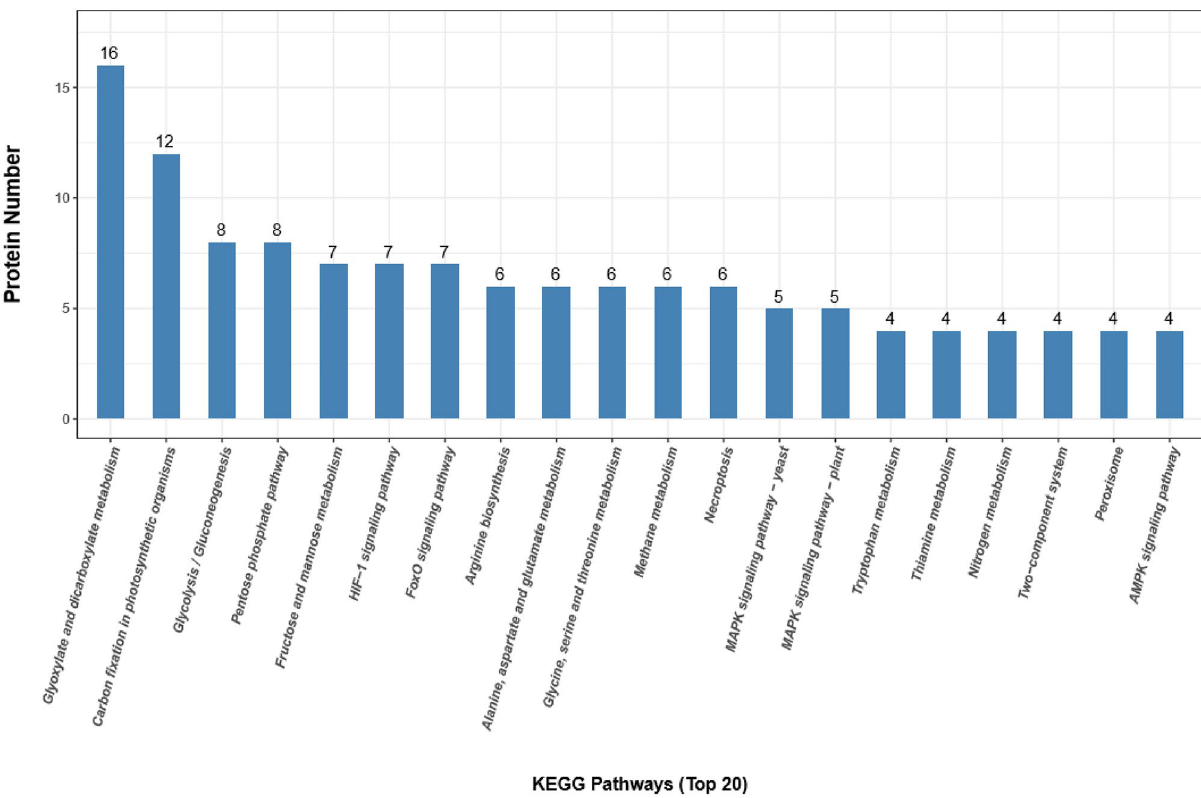
Figure 4. Kyoto Encyclopedia of Genes and Genomes (KEGG) pathway enrichment analyses for the 17K-interacting host genes 14